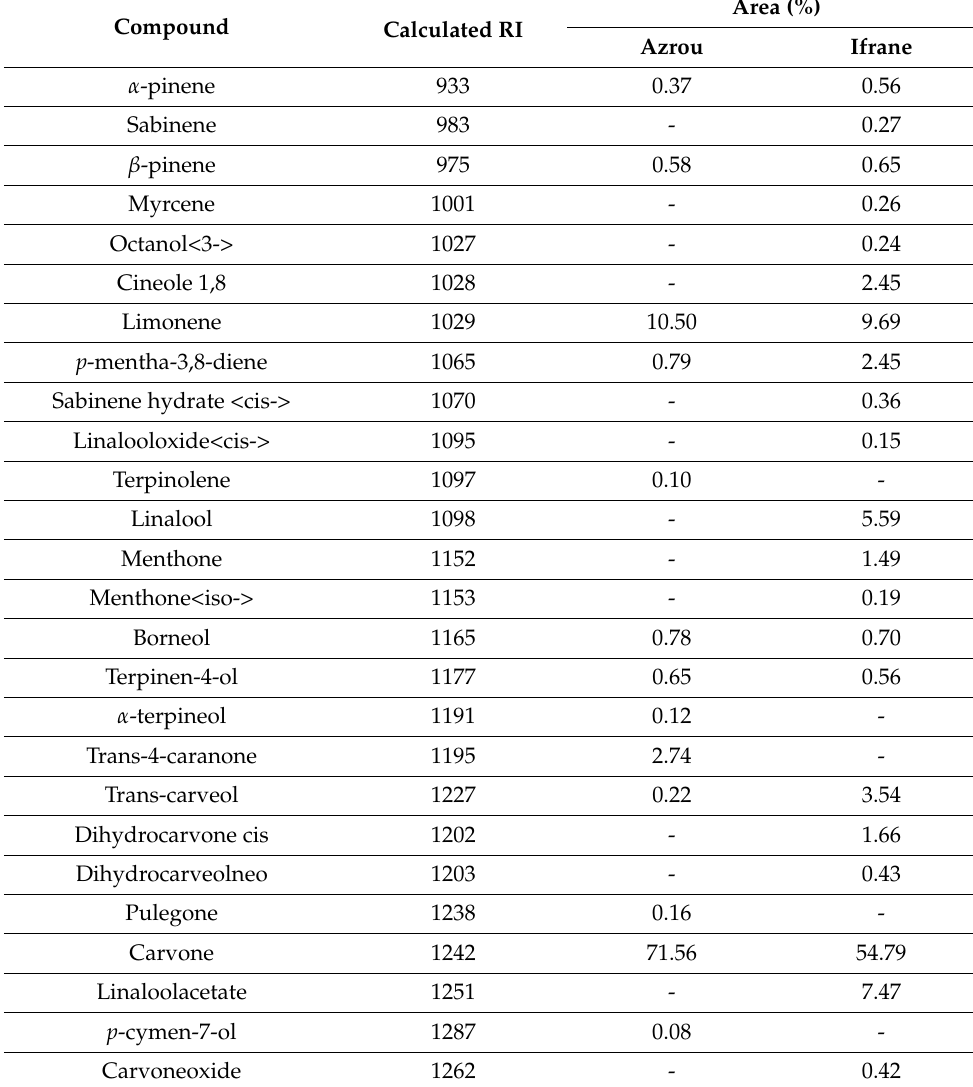
Table 5. Chemical composition of M. spicata (L.) EOs from the Middle Atlas.